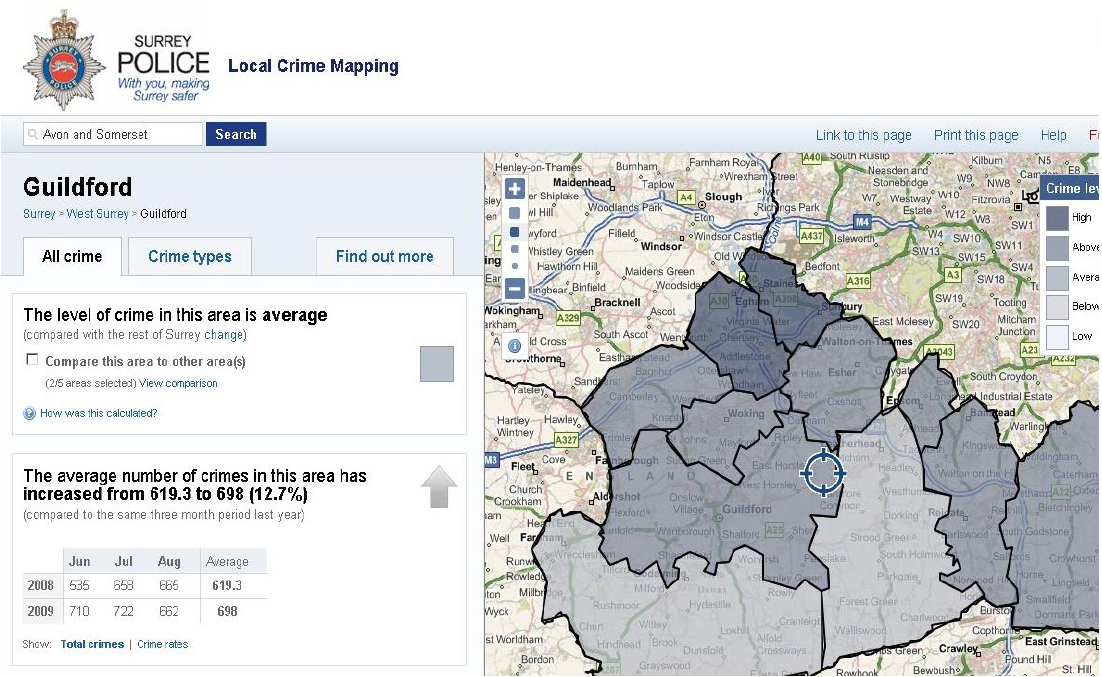
Figure 2: Screenshot of the early crime mapping website, maps.police.uk (at neighbourhood level for Guildford, Surrey Police)